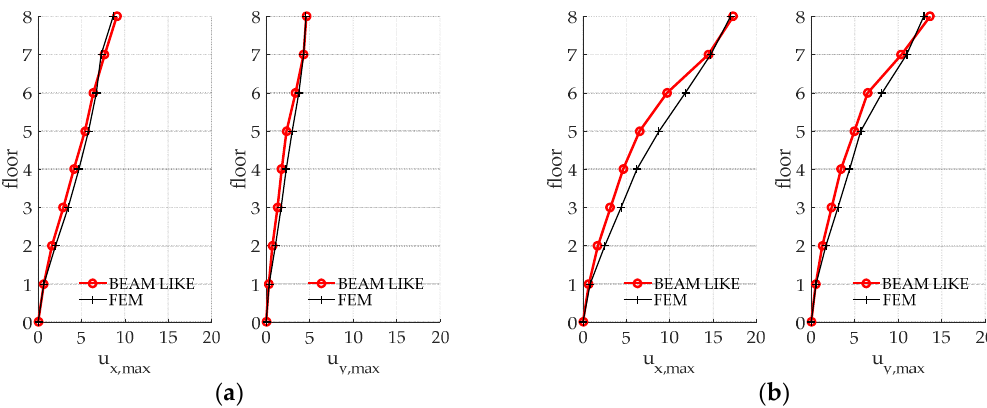
Figure 15. Eight-storey benchmark. Maxima floor displacements in the ( a ) Santa Venerina and ( b ) L’Aquila earthquakes.